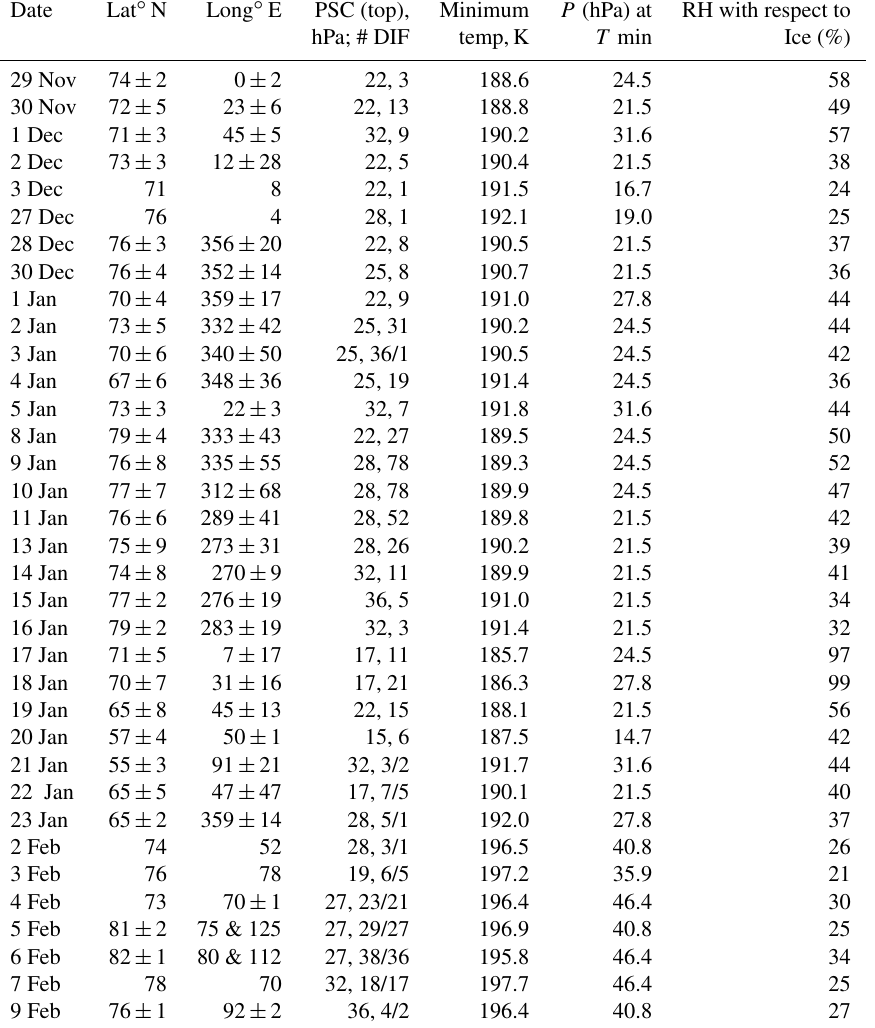
Table 1. Occurrences of signatures of PSCs in the LIMS V6 ozone profiles of 1978/79. Central latitude and longitude locations of the PSCs and their extent ( ± in degrees) are given for each day that they are found along with the average pressure level (in hPa) at which those perturbing effects are absent, or PSC top , for pressure levels between 14.7 and 46.4hPa. The number of profiles where the DIF threshold was met is indicated to the right in the column for PSC top , and the number of “false positives” is given to the right of the slash symbol (e.g„ three scans met the DIF criterion on 2 February and one of those was a “false positive” denoted as 3 / 1). The minimum temperature in the set of profiles and its pressure level is given in the next two columns. Calculated relative humidity (RH in %) with respect to ice is in the last column, based on an ambient water vapor mixing ratio of